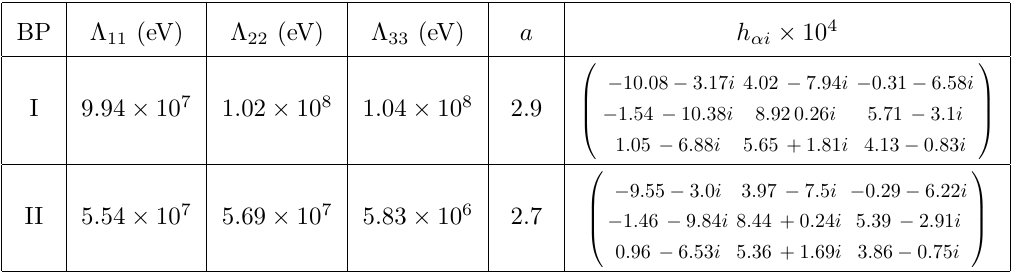
Table 3 . Numerical estimation of the two Yukawa coupling matrices which are obtained for the sets of benchmark points (BP) tabulated in table 2. Reference scalar masses are considered as M φ = { 10 7 , 10 7 . 1 , 10 7 . 2 } i